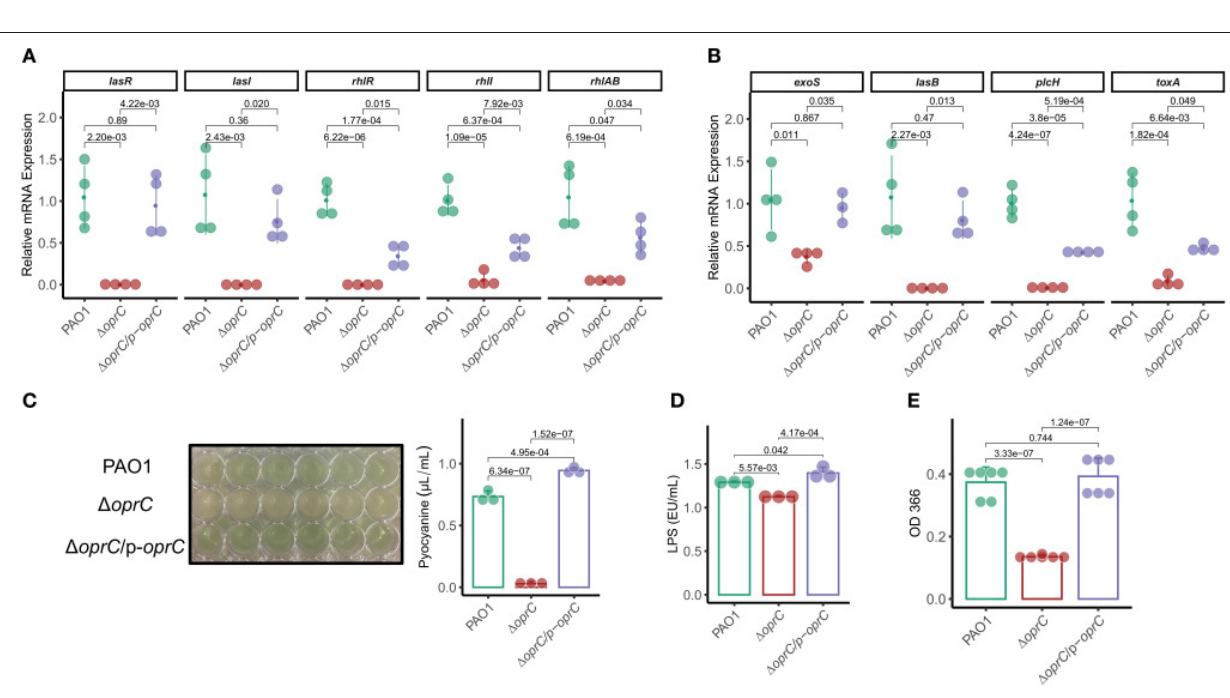
1 oprC , we reasoned that QS system might be affected by the deletion mutation. We then measured expression levels of the genes known to be involved in the QS system. The oprC -deficient